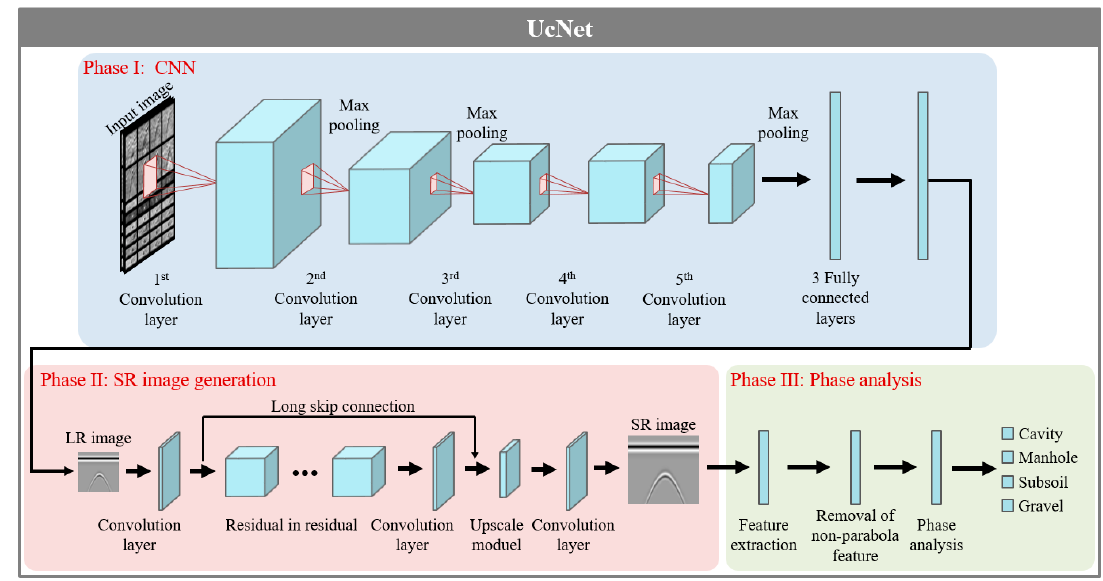
Figure 2. Overview of underground cavity detection network (UcNet): LR and SR denote the low-resolution and super-resolution, respectively.